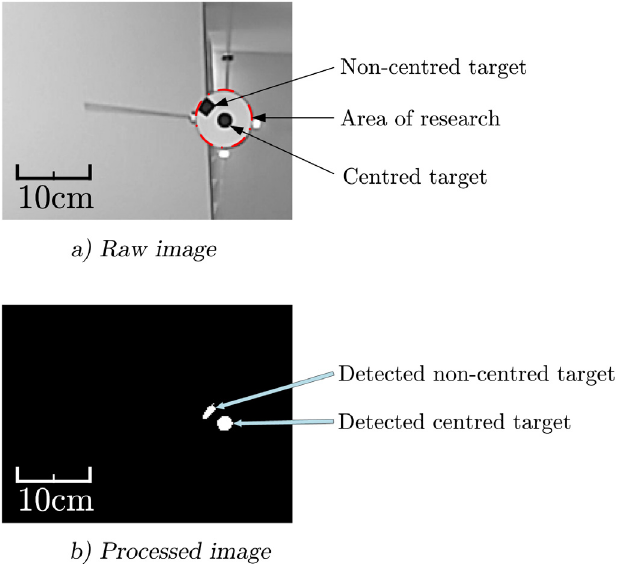
Fig. 4. Comparison of a raw (a) and a processed frame (b) extracted from a rotational movement.